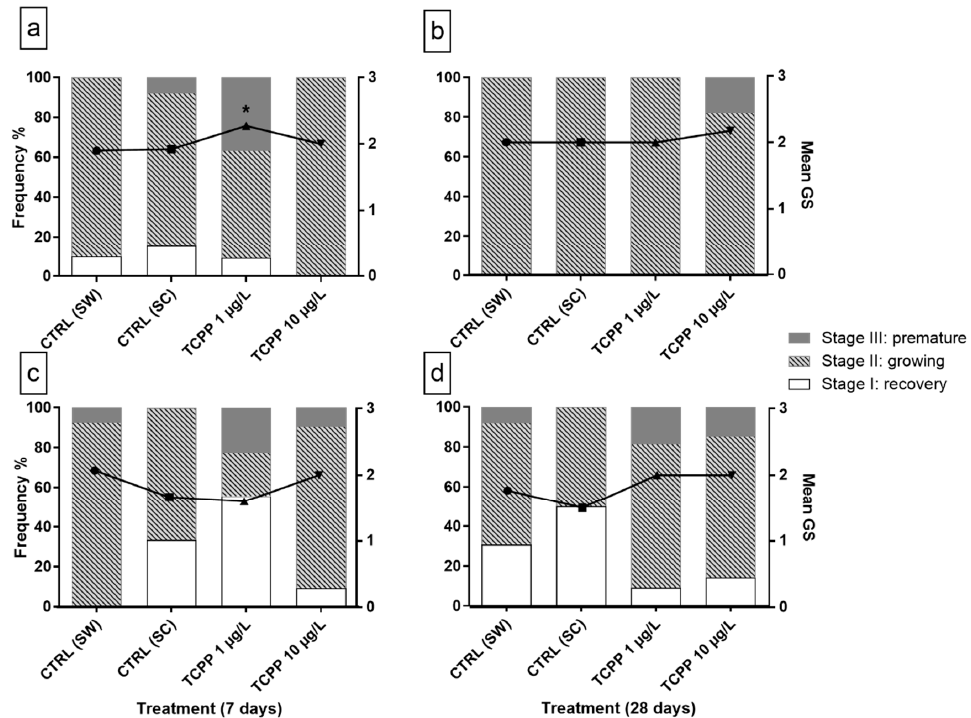
Figure 1. Relative frequencies of the gametogenic stages in histological sections of female ( a , b ) and male ( c , d ) P. lividus sea urchins exposed for 7-d ( a , c ) and 28-d ( b , d ) in 2016 (n = 7 to 17). The black line is the weighted average of the gametogenic stage (GS) for each treatment (Table S1). Asterisk indicates significant ( P < 0.05) differences with respect to solvent control (CTRL (SC)).